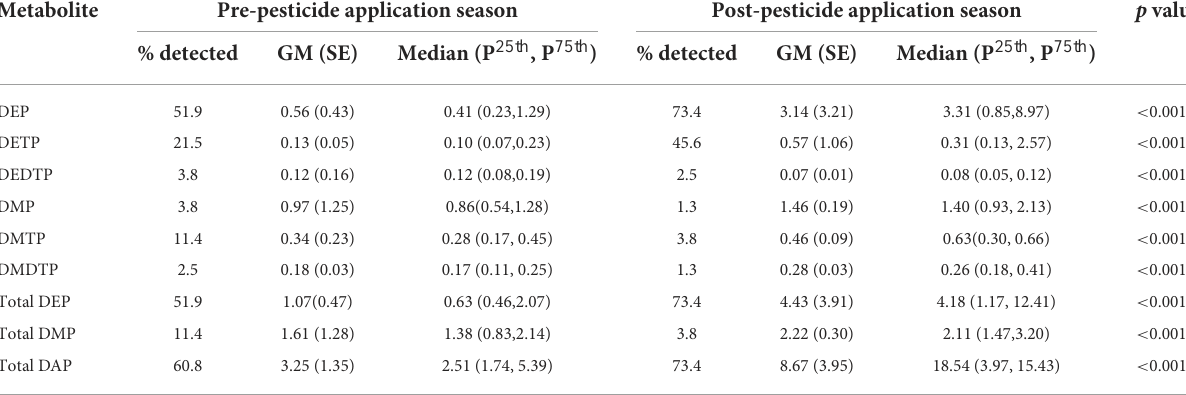
TABLE 2 Urinary OP metabolite levels ( µ g/g creatinine) between pre-and post-pesticide application seasons ( n = 79).